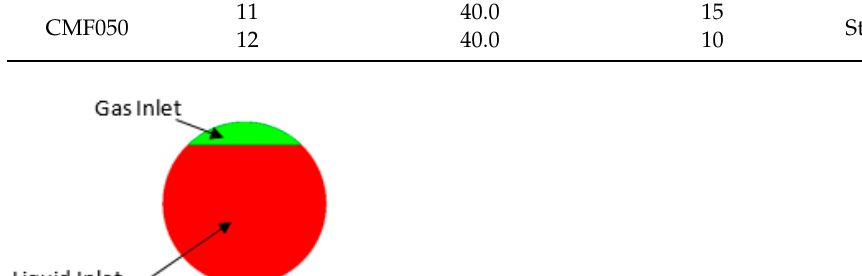
Figure 4. A typical liquid hold-up inlet boundary condition for the stratified flow regime simulation of CFM operation (9% GVF, 60.8 kg/min).